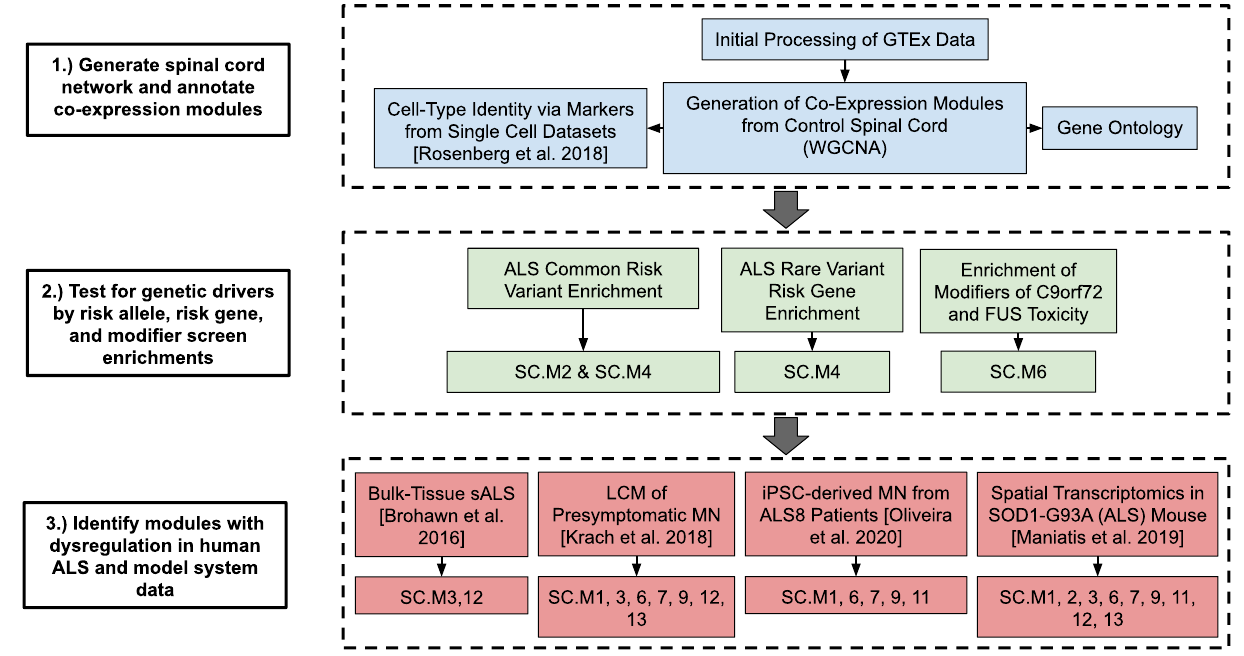
Figure 1. Overview of spinal cord co-expression network analysis. Flow diagram of analyses in this study. A co-expression network was generated using the GTEx cervical spinal cord expression data and Weighted Gene Co-Expression Network Analysis (WGCNA). Modules were annotated by their associated biological processes, hub genes, and cell-type identities. Modules were then assessed for their enrichment of ALS genetic risk factors and analyzed for differential expression in RNA-seq data from human ALS tissues and model system studies 12,13,22,23